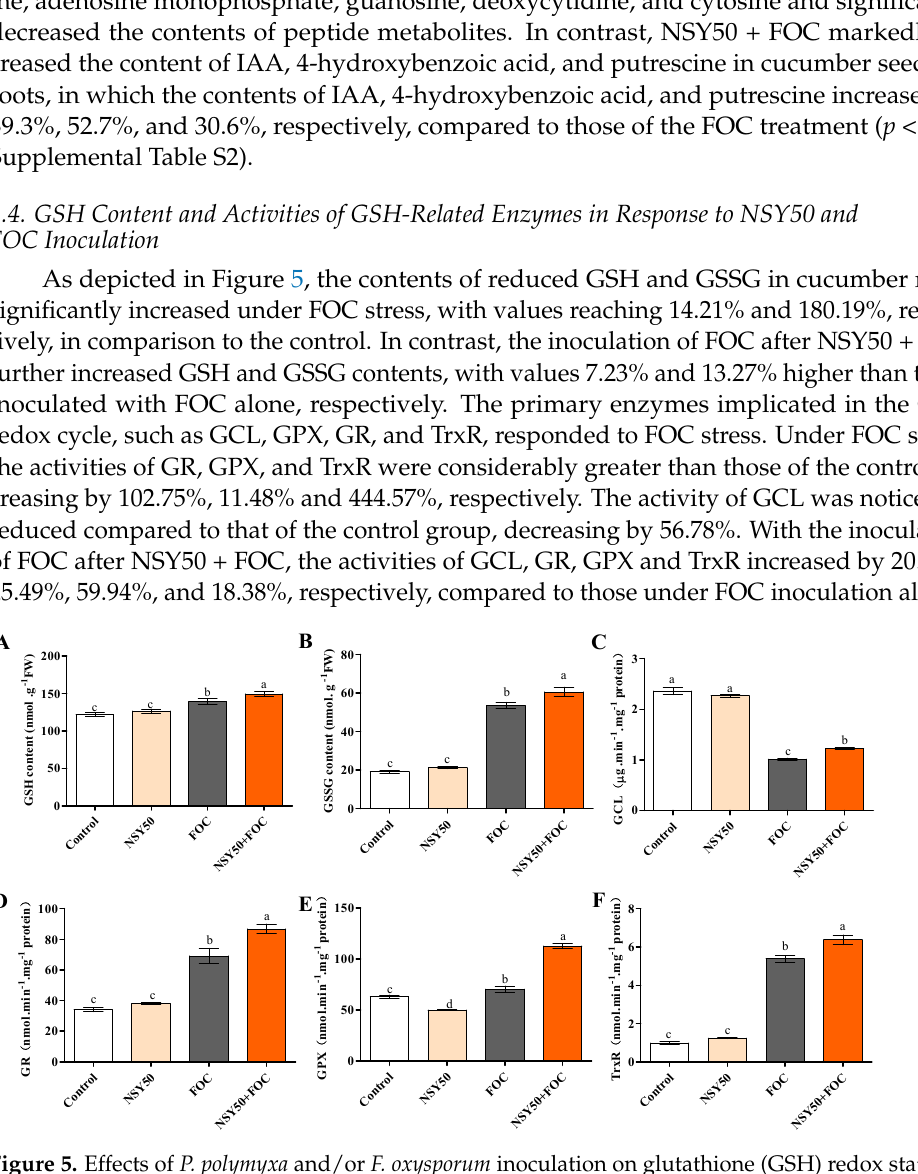
Figure 5. Effects of P. polymyxa and/or F. oxysporum inoculation on glutathione (GSH) redox status in the roots of cucumber seedlings. ( A ) GSH content , ( B ) GSSG content, ( C ) Activity of GCL, ( D ) Activity of GR, ( E ) Activity of GPX, ( F ) Activity of TrxR. Values are the means ± SD, n = 3 (biological replicates), and different letters (a > b > c > d) indicate a significant difference at p < 0.05, as determined by Duncan’s multiple-range test.